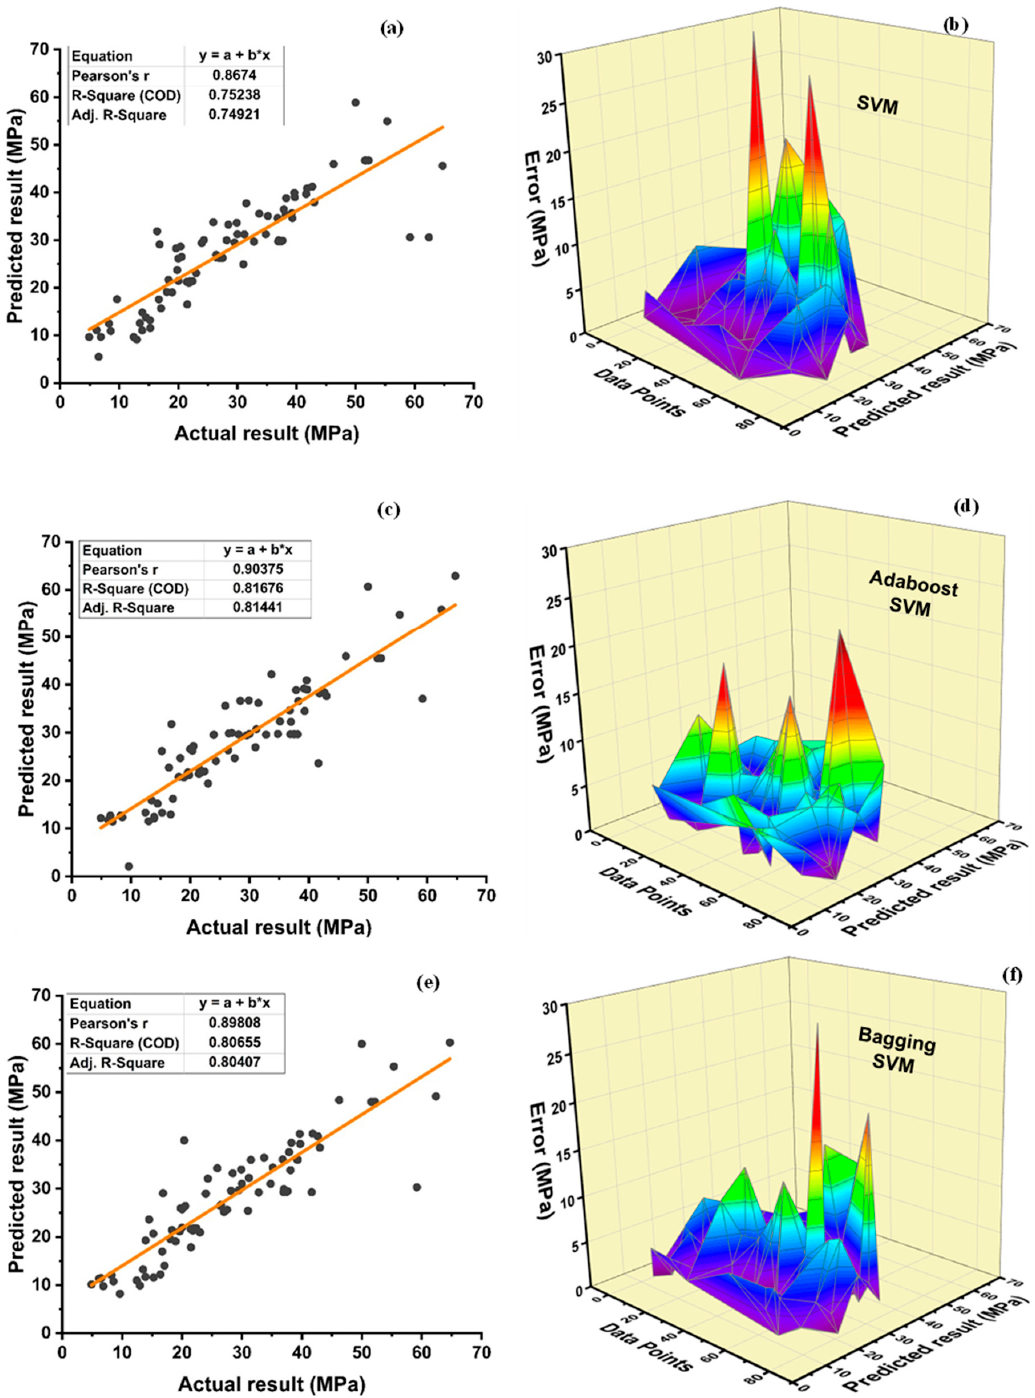
Figure 16. Compressive strength: ( a ) SVM regression model; ( b ) SVM regression model error distribution; ( c ) SVM-Adaboost regression model; ( d ) SVM-Adaboost regression model error distribution; ( e ) SVM-Bagging regression model; ( f ) SVM-Bagging regression model error distribution.